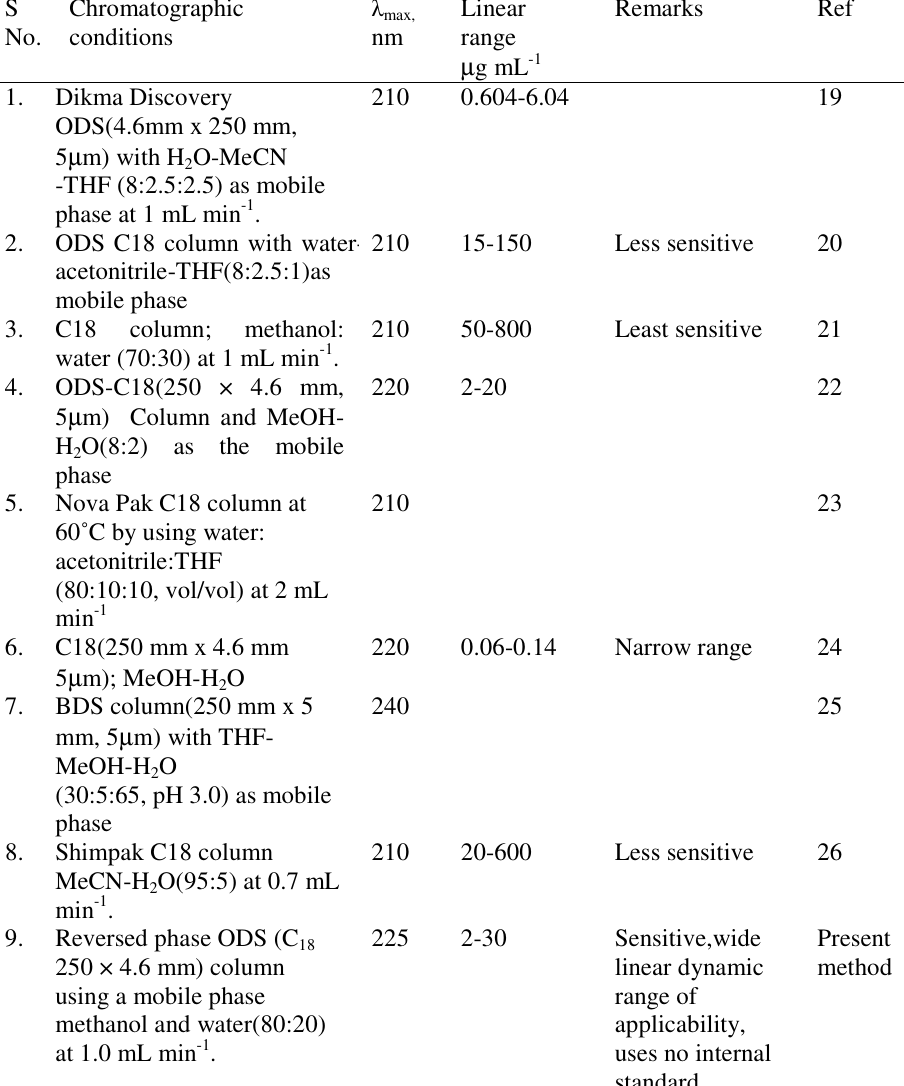
Table 1. Comparision of existing HPLC methods with proposed